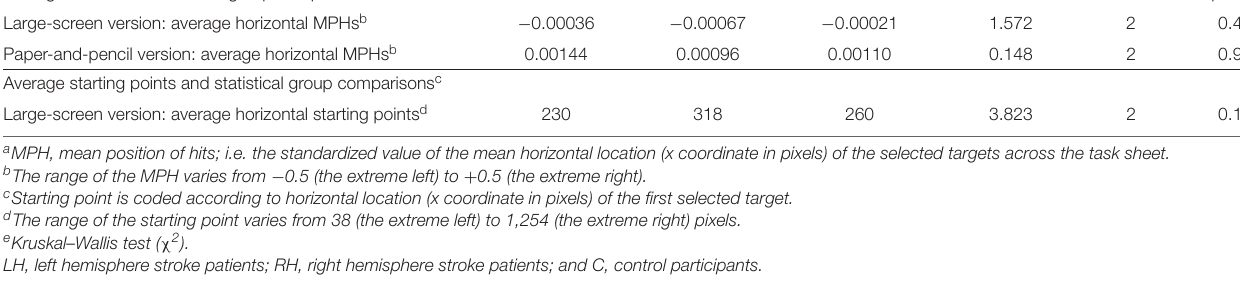
The twinkle task Average MPHs and statistical group comparisons